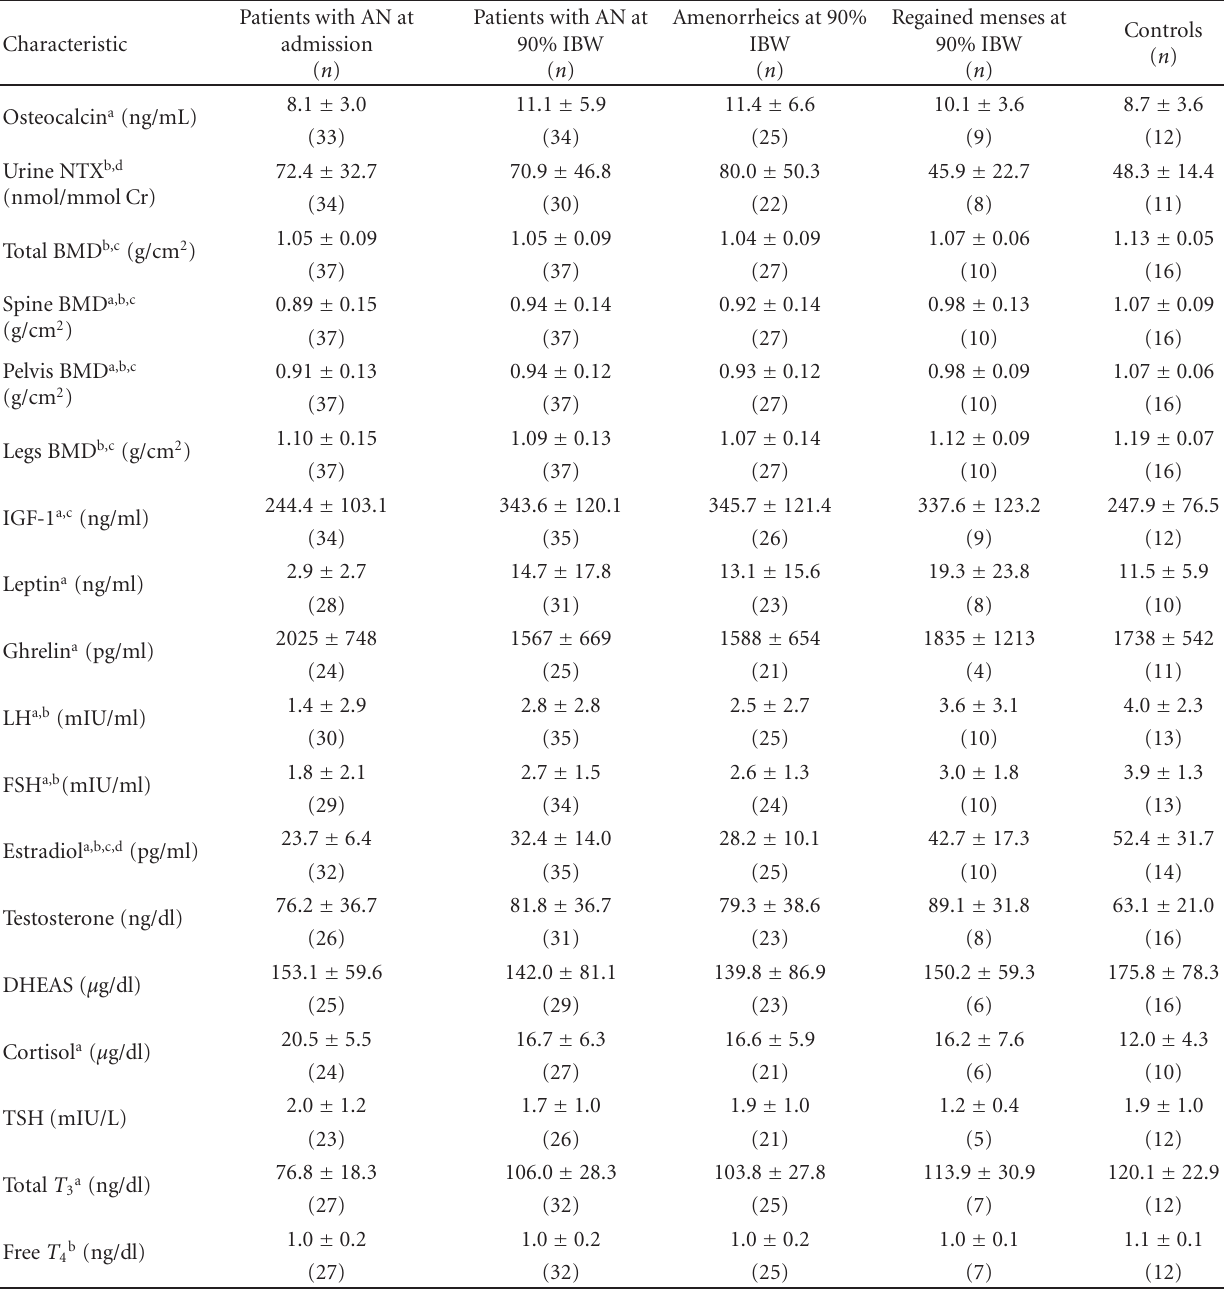
Table 2: Bone marker, BMD, and hormone data (mean ±